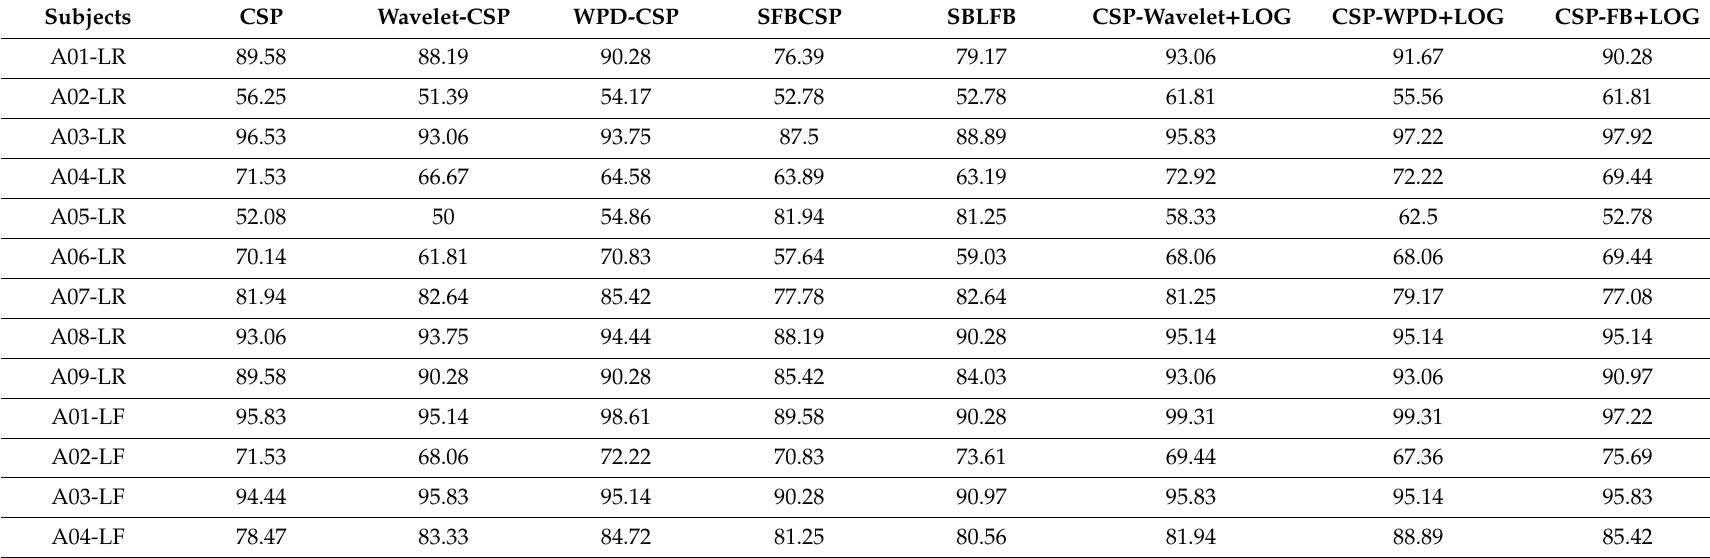
Table 3. Classification accuracy (Dataset